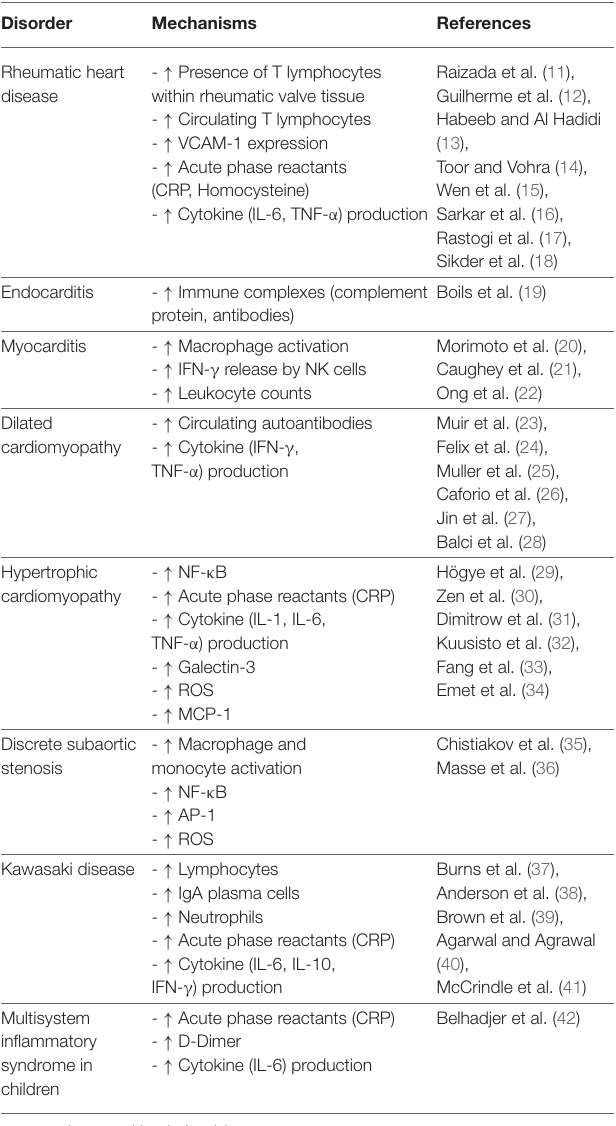
TABLE 1 | Immune and Inflammatory markers associated with acquired heart